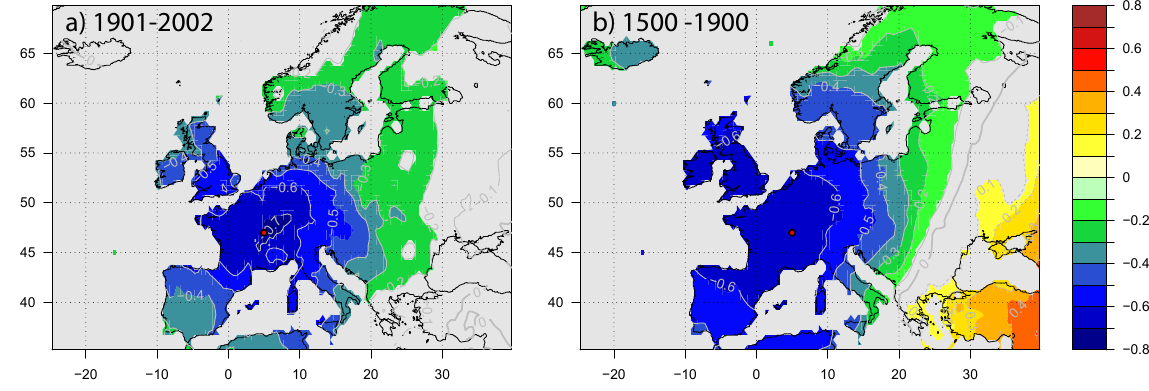
Fig. 3. Correlation of the GHD with the near-surface temperature in spring/summer (MAMJJA) from Luterbacher et al. (2004) for different periods: (a) 1901–2002 (b) 1500–1900. Areas of significant correlation are coloured ( p < 0.05).